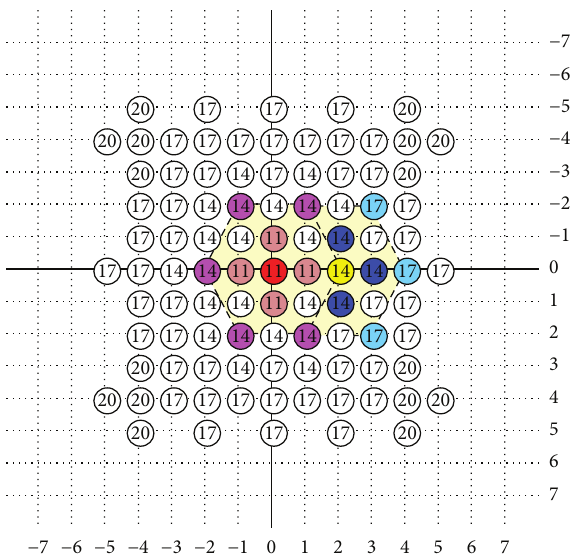
Figure10:NumberofsearchpointssavedbyHEXBScomparedwith DS.